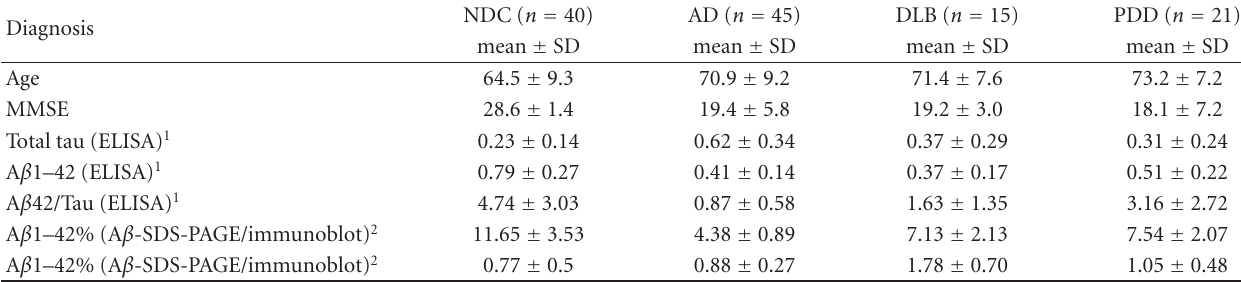
Table 1: Age, MMSE, Total tau, A β 42, A β 1–42%, and A β 1–40 ox % in the CSF of the diagnostic groups.